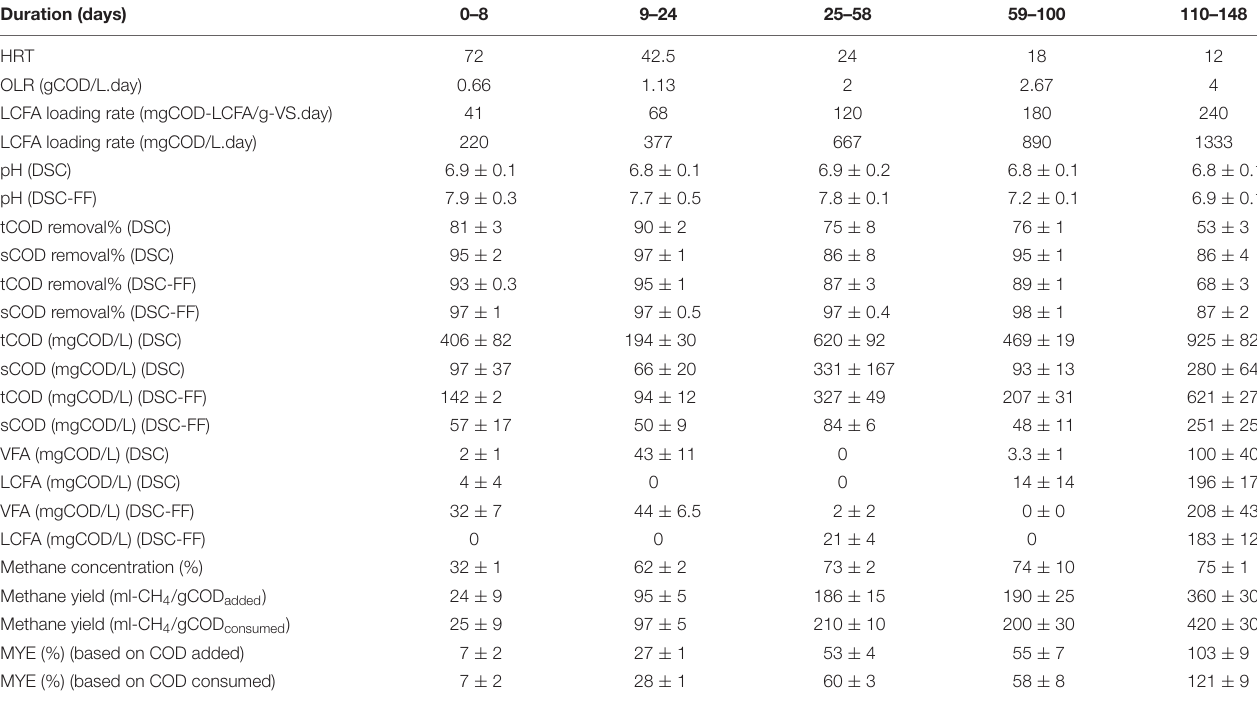
FIGURE 2 | Total COD (tCOD) and soluble COD (sCOD) removals and daily methane production from DSC-FF reactor at the different HRTs of 72, 42.5, 24, 18, and 12 h. TABLE 2 | Operational conditions and process performance of the DSC-FF reactor and separately of DSC at the different HRTs of 72, 42.5, 24, 18, and 12 h. Duration